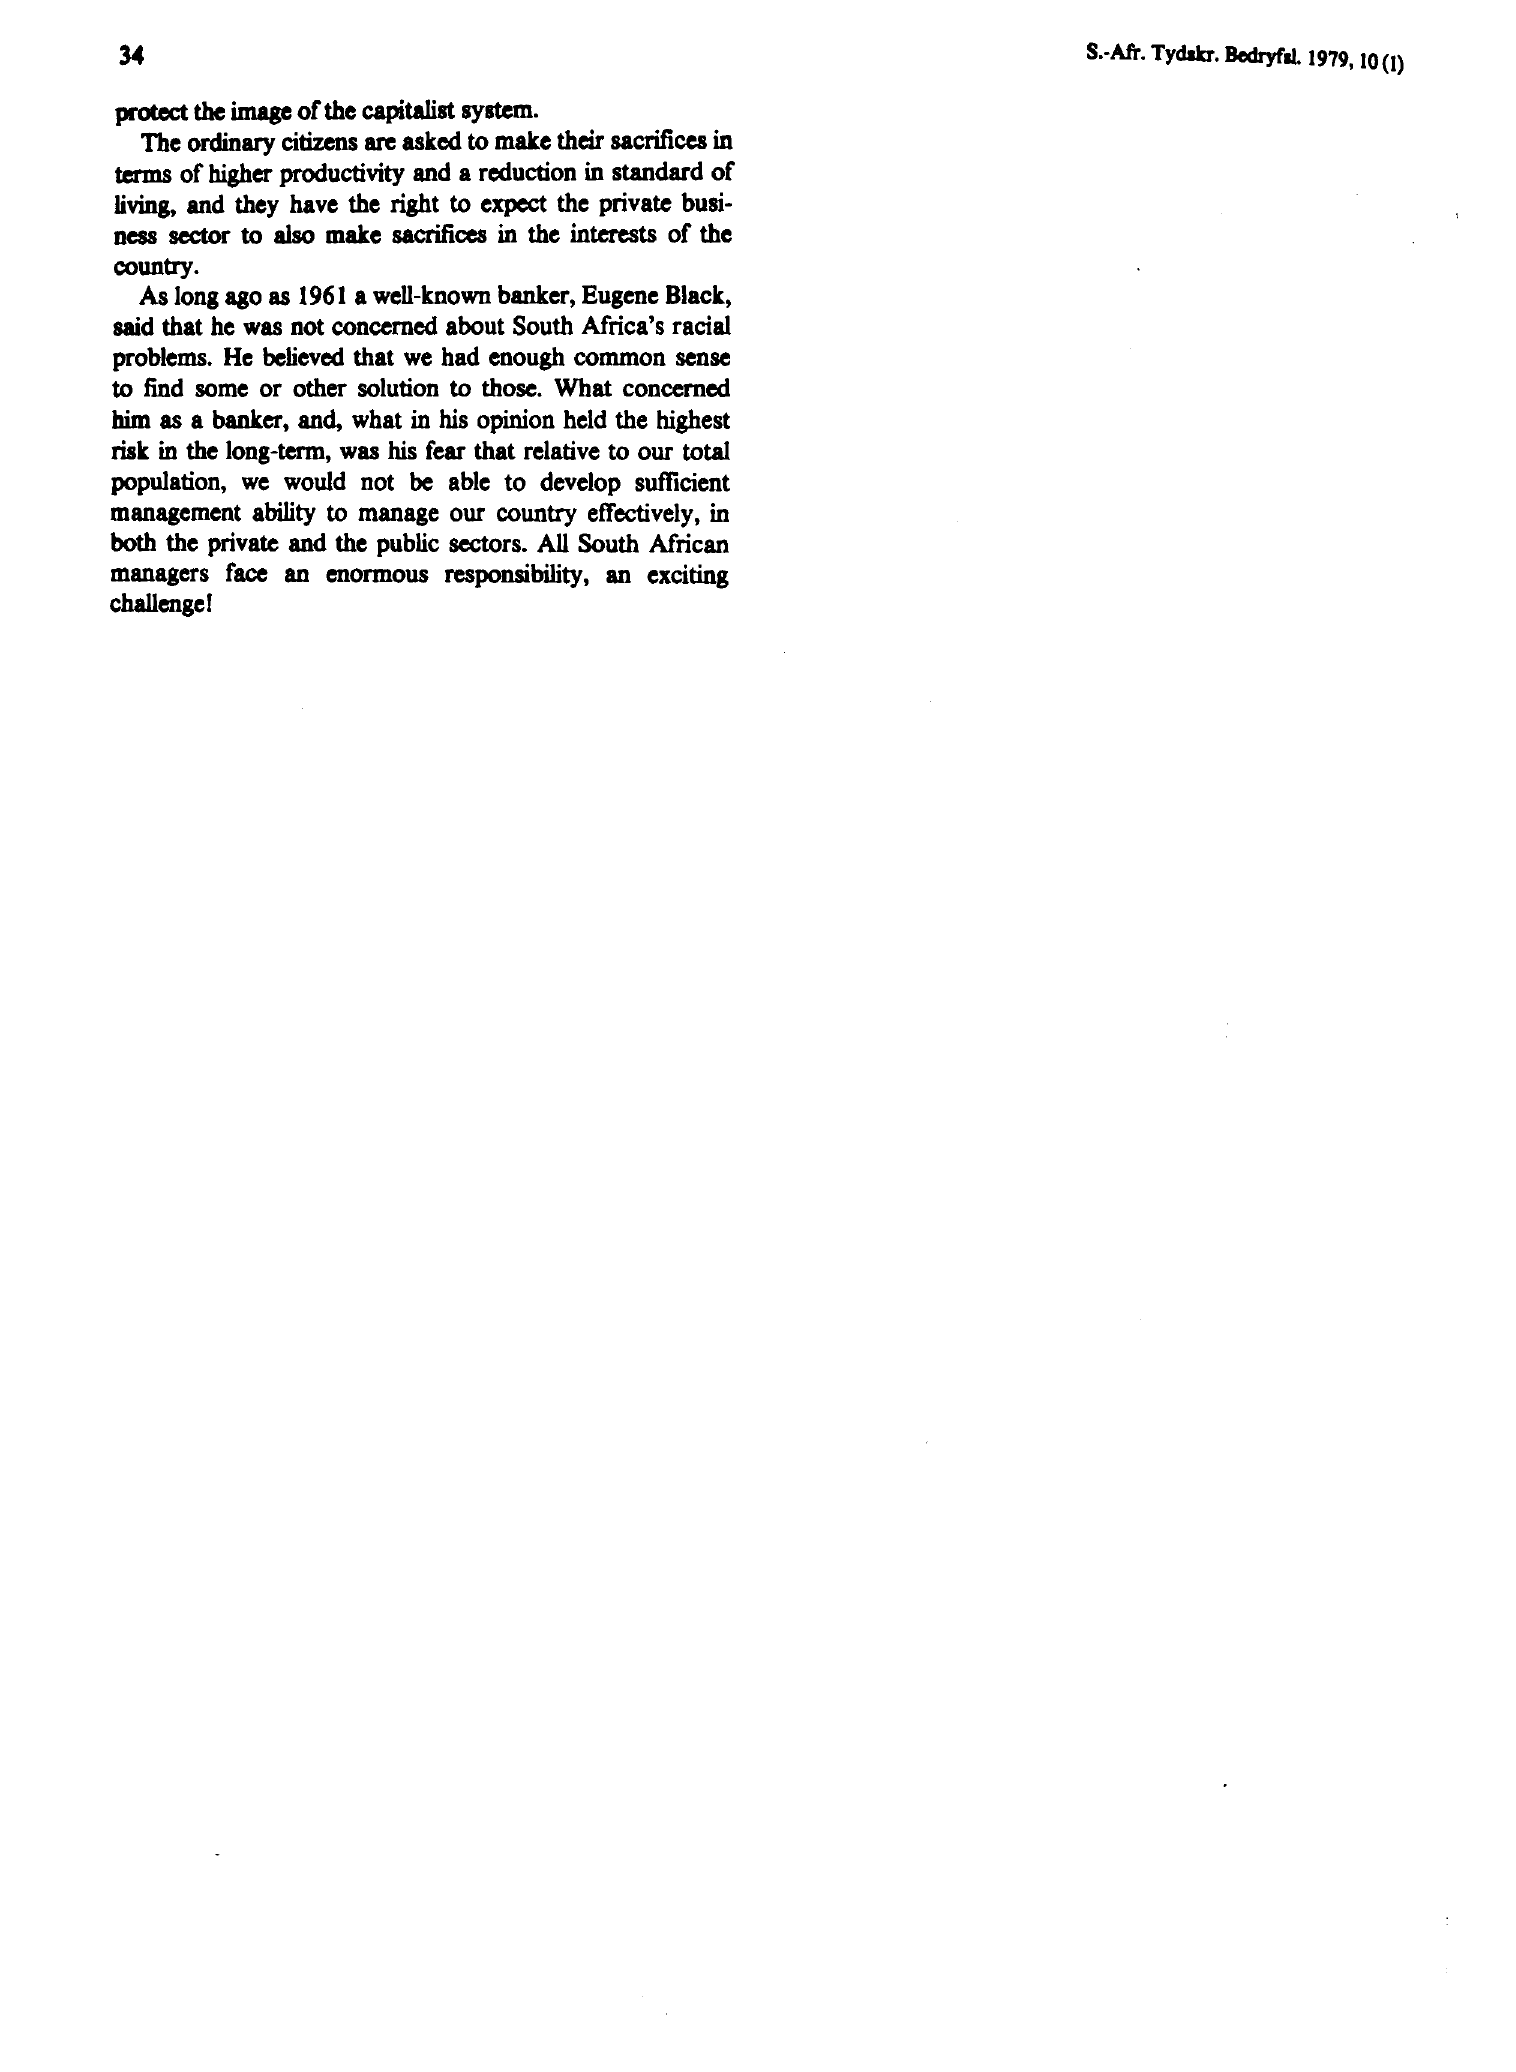
protect the image of the capitalist